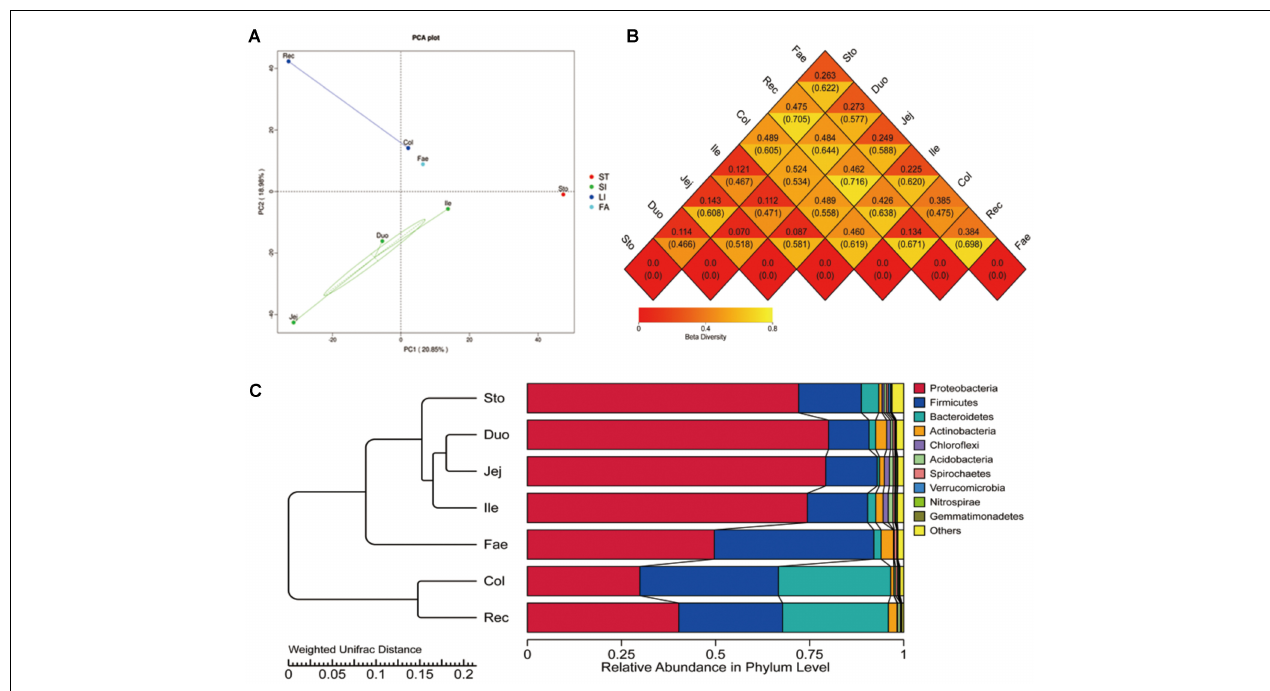
FIGURE 1 | Beta diversity of microbiota in red panda GIT. (A) Principal component analysis (PCA) with unweighted uniFrac of bacterial community in GIT samples. (B) Heatmap of the distance matrix, number above and under the central line in each rhombus is calculated using the weighted uniFrac and unweighted uniFrac methods, with higher values showing significant differences. (C) Clustering of the microbiota at the phylum level. Sto, Duo, Jej, Ile, Col, Rec, and Fae represent samples from the stomach, duodenum, jejunum, ileum, colon, rectum, and faecal,